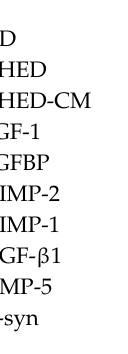
Figure S1. Characterization of the mesenchymal features of SHED. (A) Microscopic examination of SHED at passage 3 shows the fibroblast-like morphology of SHED after cultivation. (B) Flow cytometry analysis shows that SHED are negative for hematopoietic markers, CD34 and CD45, (C) and are positive for MSC markers, CD73, CD90, and